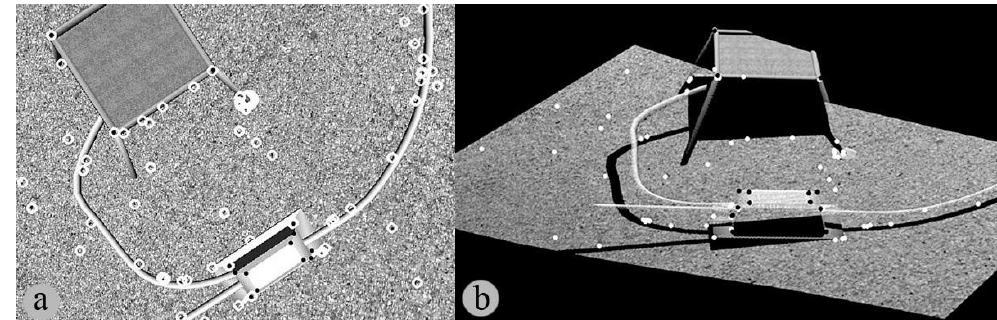
Figure 7. Identification of points belonging to the SPS object: ( a ) extraction of characteristic points by the Harris angle detector in the image taken by the camera; ( b ) a set of 3D points constructed from 2D images. All selected points in the scene are marked in white. Points belonging to SPS objects are marked in black. Six points belonging to SPS have been identified.